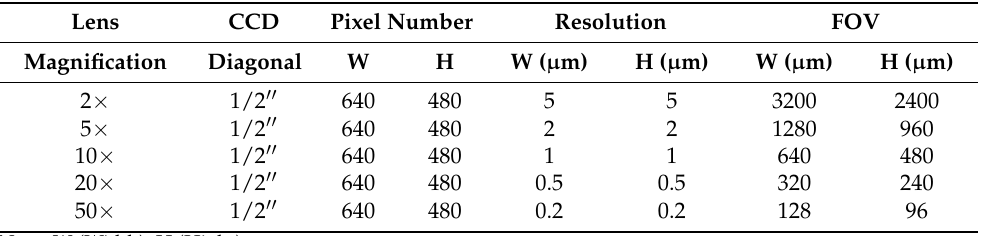
Table 2. The area-CCD illustrates the magnification, resolution, and field of view (FOV) by various lenses.